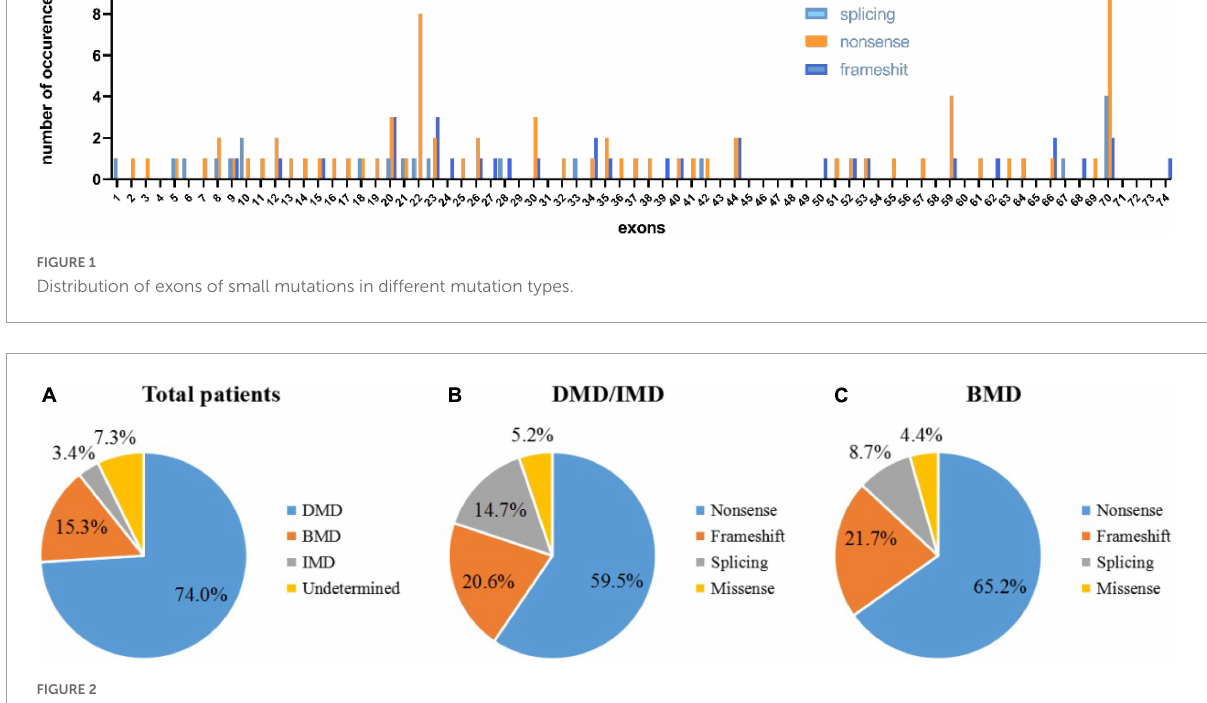
(57.5%), and 14 small insertions (42.4%). No other exon